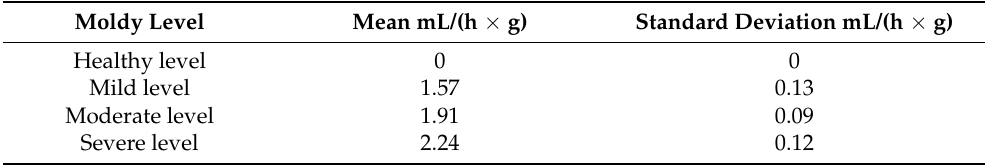
Table 1. Catalase (CAT) activity value of maize with different moldy levels. Moldy